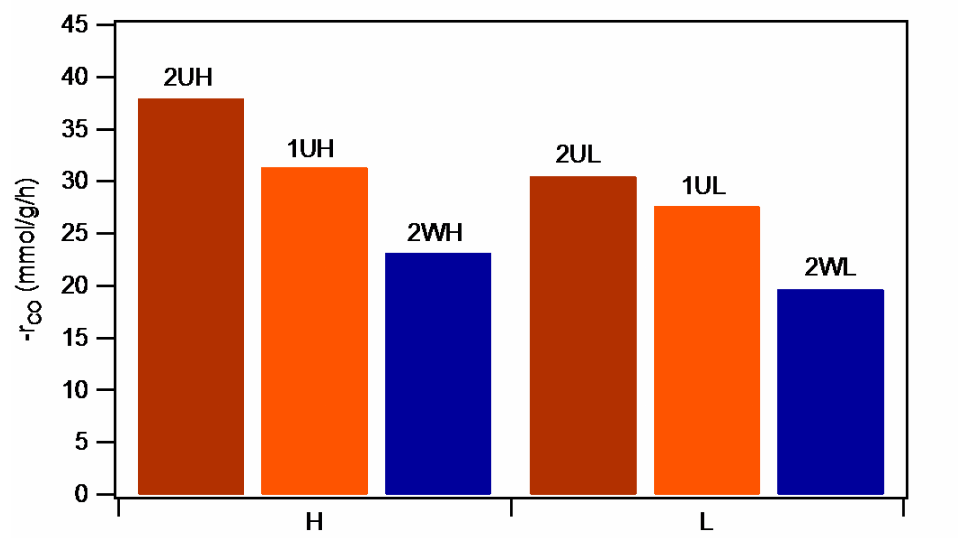
Figure 8. Effects of washing and drying on rate of reaction for 1S and 2S catalysts at 250 °C. 1WH and 1WL are not shown to avoid confusion over effects of low potassium